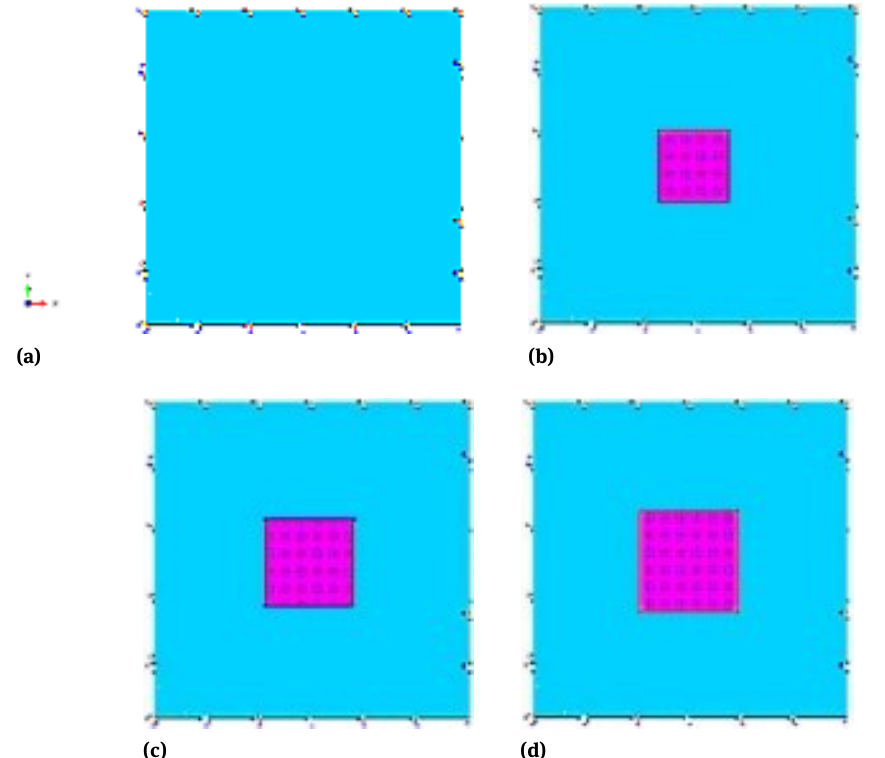
Figure 2: FEM models of ship sandwich plate with damage ratios variations: (a) Intact sandwich plate, (b) 5% damaged sandwich plate, (c) 7.5% damaged sandwich plate, and (d) 10% damaged sandwich